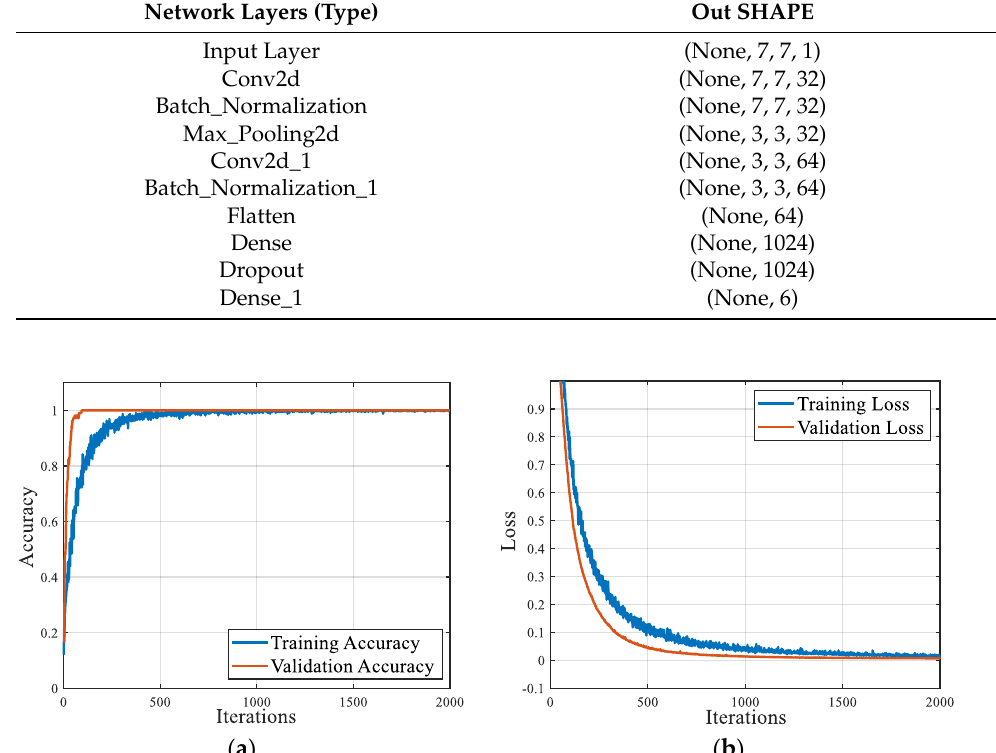
Table 2. CNN model structure.